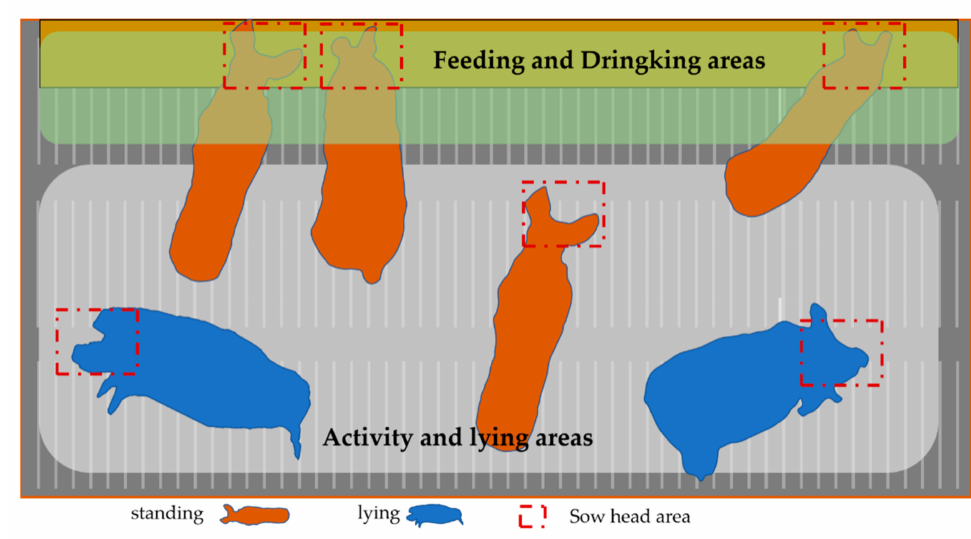
Figure 6. A schematic diagram of sows in the pen. Note: In order to ensure that each sow has a larger living space, three sows could be accommodated in the real pen at a time. In order to better illustrate the current situation, there are six sows drawn in this schematic diagram.